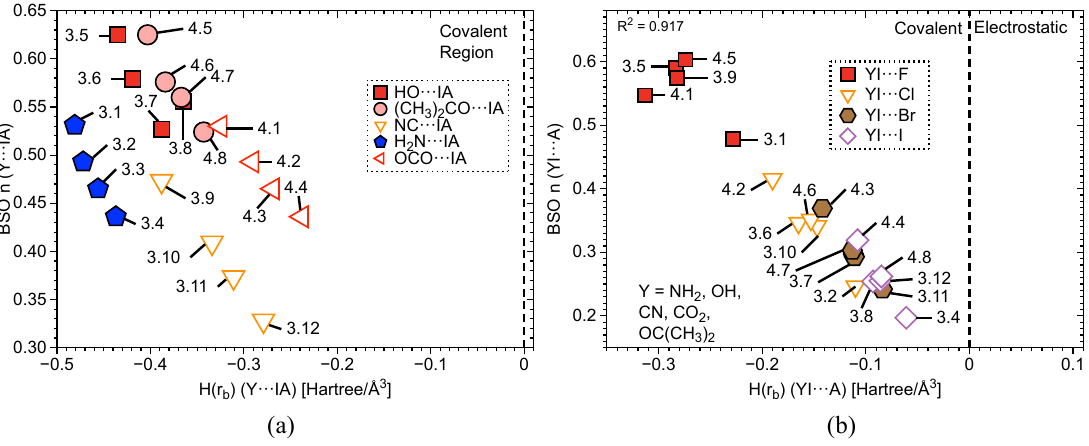
Figure 5. ( a ) Comparison of BSO n with H ( r b ) of iodine-non halogen axial atom (Y · · · IA) interactions in complexes 3.1–4.8 and ( b ) a comparison of BSO n with H ( r b ) of axial halogen-iodine (YI · · · A) interactions in complexes 3.1–4.8 . The vertical dashed line separates the electrostatic region from the covalent